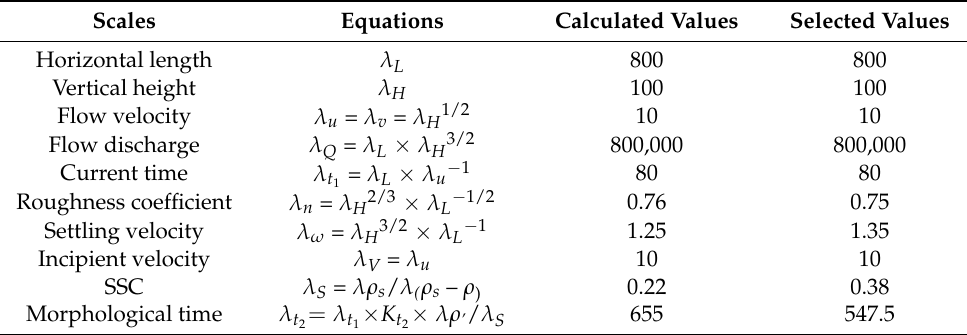
Table 1. Calculated and selected scale values of the experimental